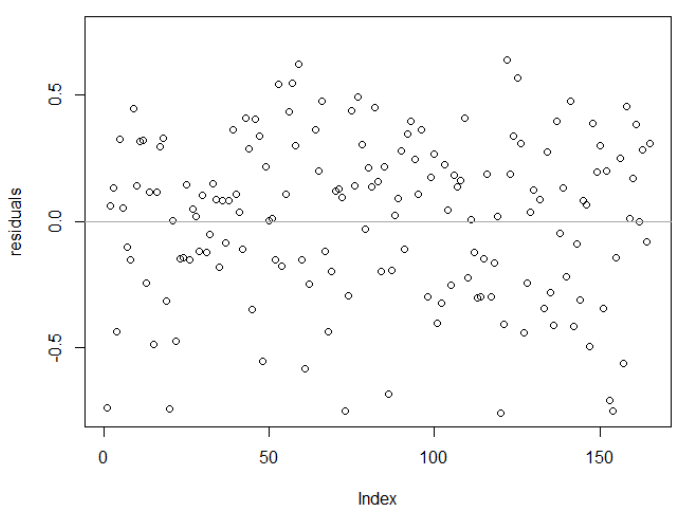
Figure 11. Regression for cell B.